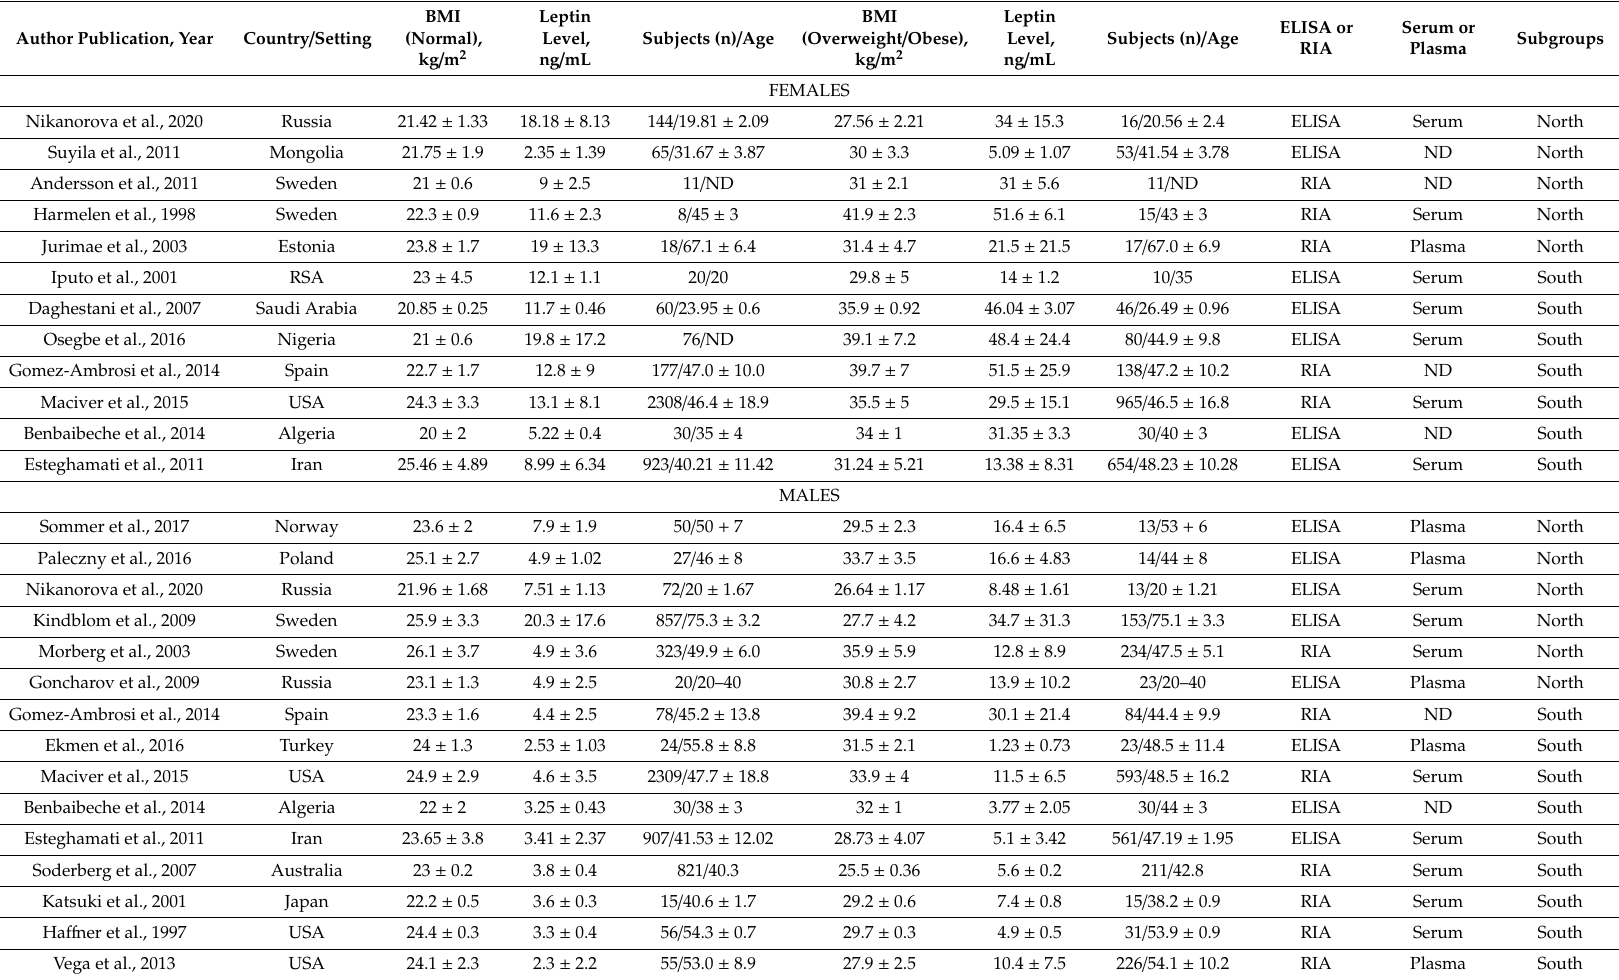
Table 1. Characteristics of the individual studies included in this